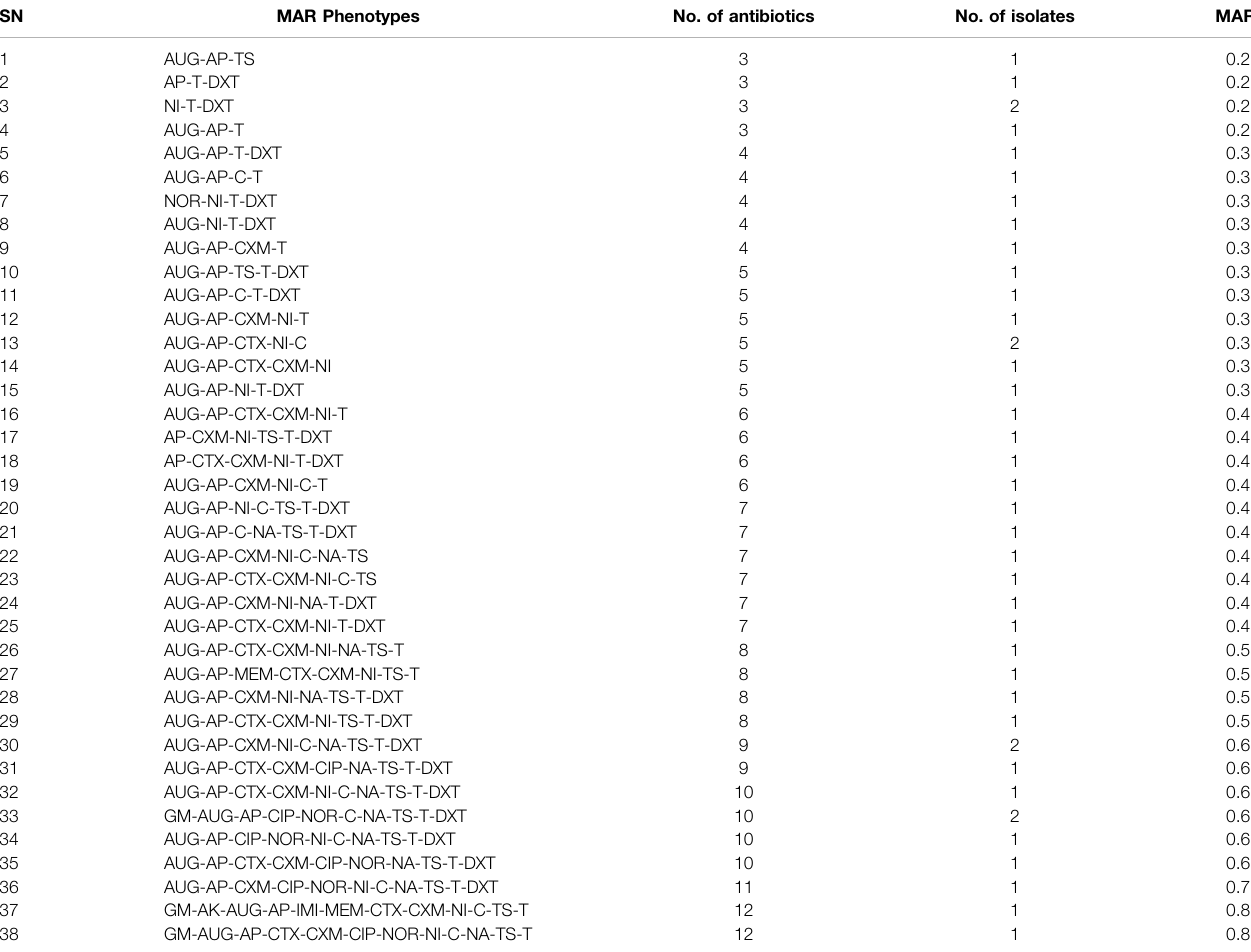
TABLE 2 | The MARPs and MARI of the pathogenic strains of E. coli retrieved from irrigation water samples. SN